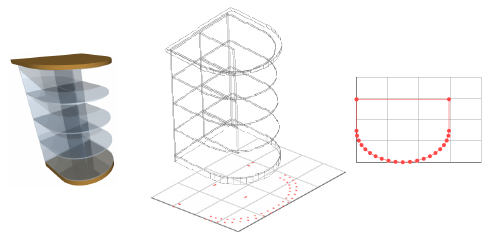
Figure 3: Deriving a 2D representation of a museum display cab- inet from a 3D IFC b-rep model containing 1333